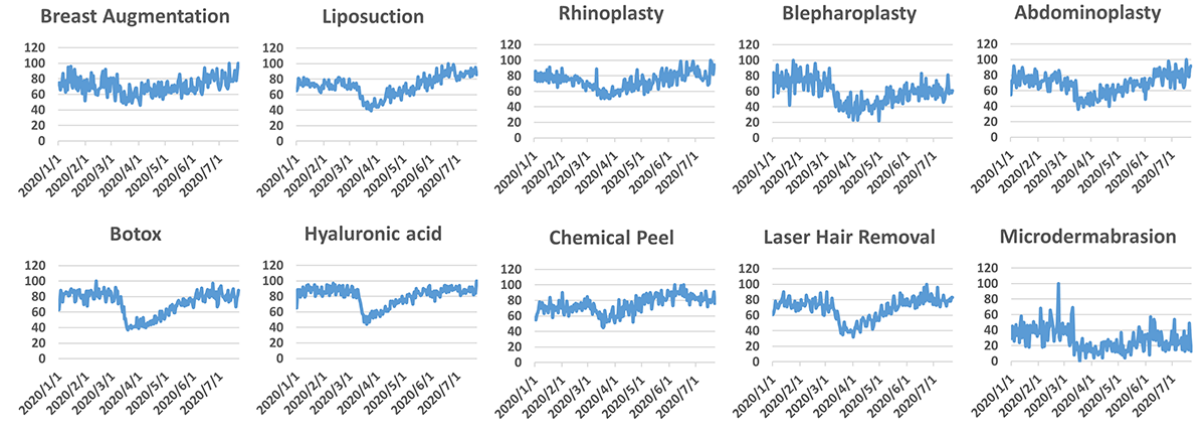
Figure 2. Google Trends indices for the 10 most common cosmetic surgical and minimally invasive plastic procedures. The searched topics are shown rather than the actual